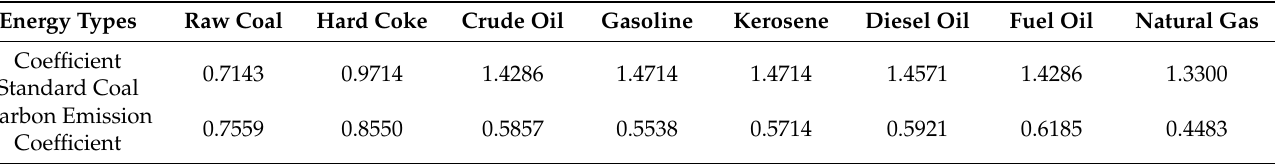
Table 1. Carbon emission calculation parameters of 8 major fossil energy sources.